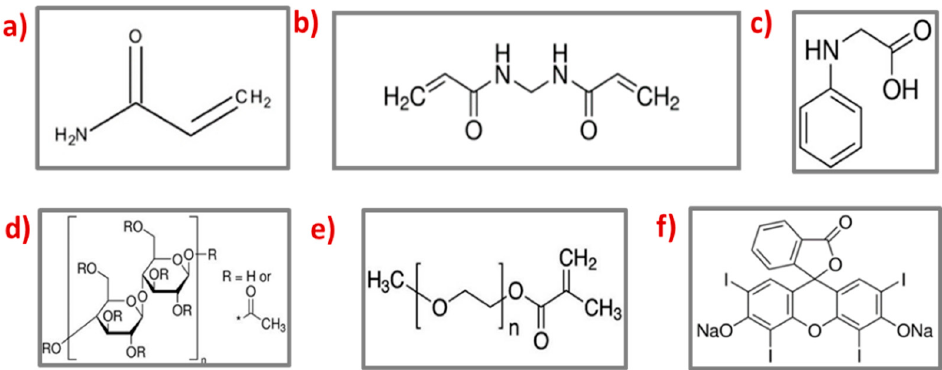
Figure 1. Chemical composition of the cellulose-based photopolymer: ( a ) acrylamide monomer; ( b ) N-N’methylenebisacrylamide—crosslinker; ( c ) NPG free radical initiator; ( d ) cellulose—binder; ( e ) polyethylene glycol–pore control agent; ( f ) erythrosine B—sensitizing dye and co-initiator.